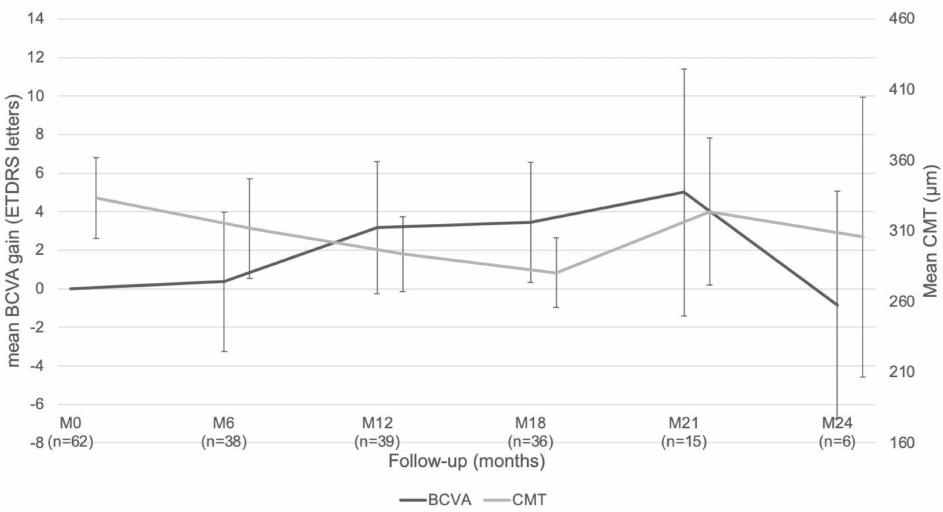
Figure 2. Mean best corrected visual acuity (BCVA) improvement and mean change in central macular thickness